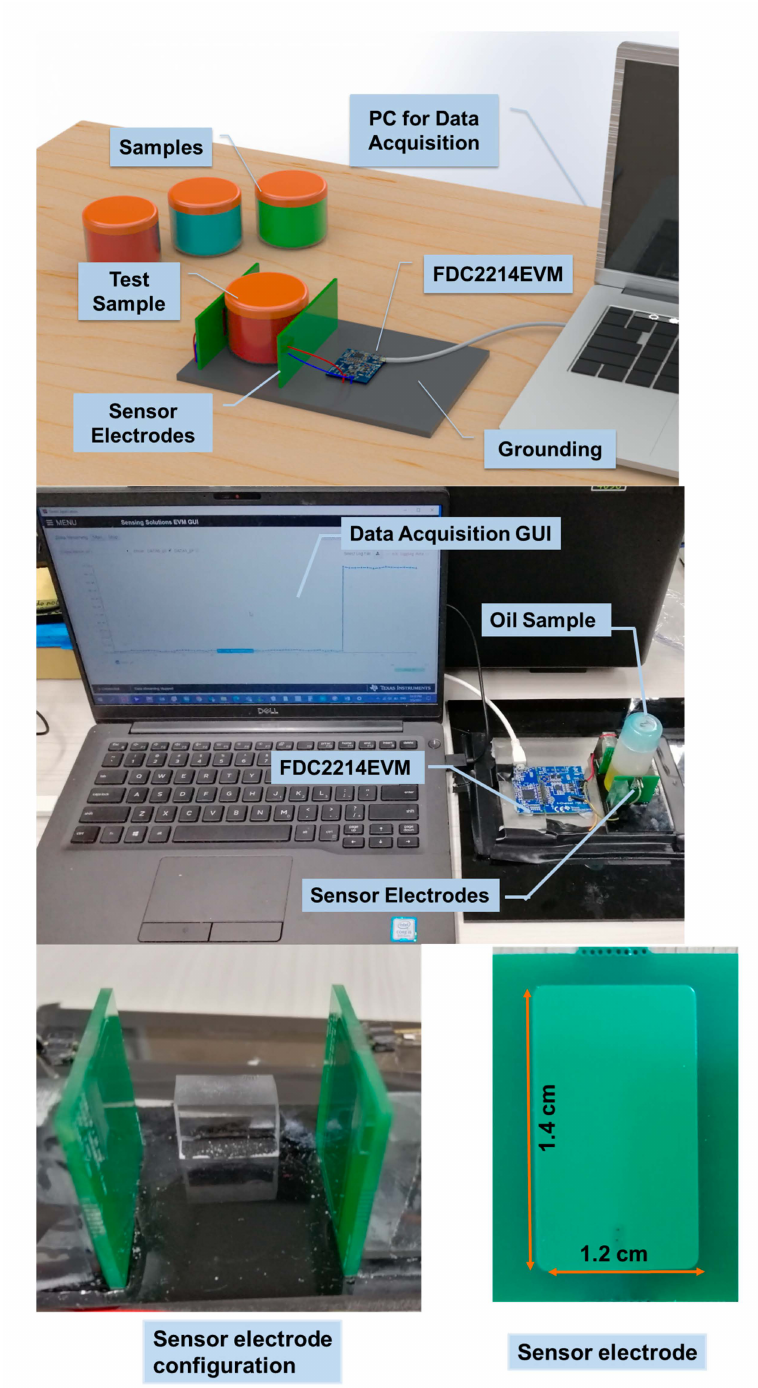
Figure 1. Capacitance-based edible oil adulteration testing setup: Schematic of the experimental setup ( top ) and the corresponding photograph ( middle ). Photographs of the parallel plate sensor configuration ( bottom-left ) and PCB fabricated rectangular-shaped sensor electrodes ( bottom-right ). To obtain the sensor calibration curve for adulteration tests, four commonly used adulterant oils, namely, OO, SOY, CAN, and CAS were mixed with EVOO in varying pro- portions and evaluated. The relative capacitance ( ∆ C EVOO /C EVOO = ( C AO − C EVOO )/ C EVOO ) of the calibration curve was calculated using EVOO as the reference (blank), where C AO and C EVOO are capacitances of EVOO oil (blank) and adulterated EVOO (blending with OO, SOY, CAN, or CAS), respectively. The slope of the sensor calibration curve (( ∆ C EVOO /C EVOO